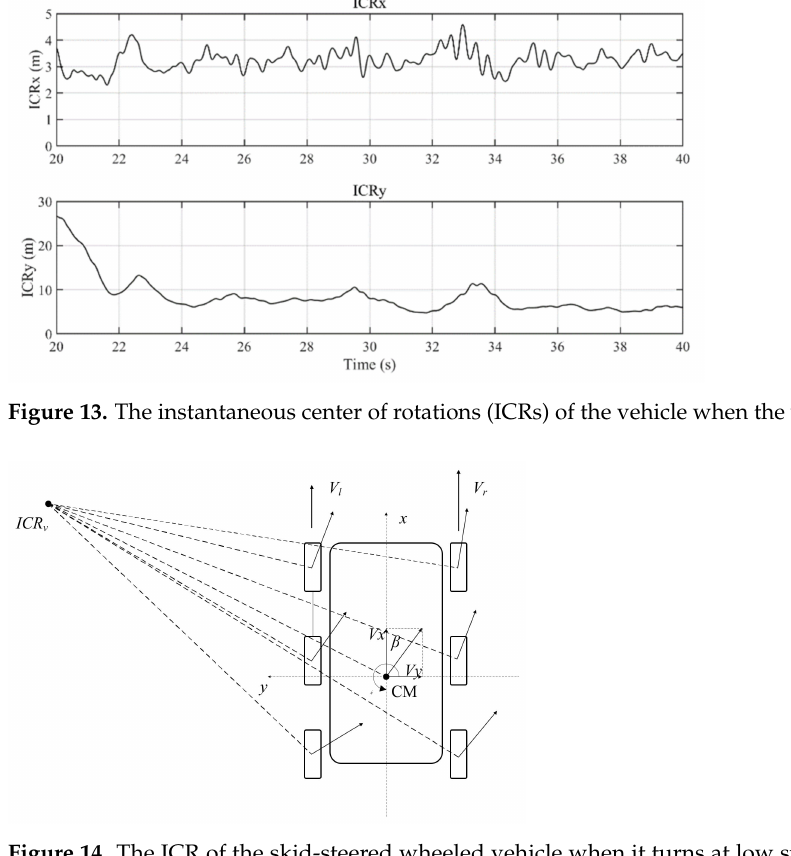
Figure 14. The ICR of the skid-steered wheeled vehicle when it turns at low speed and in a small